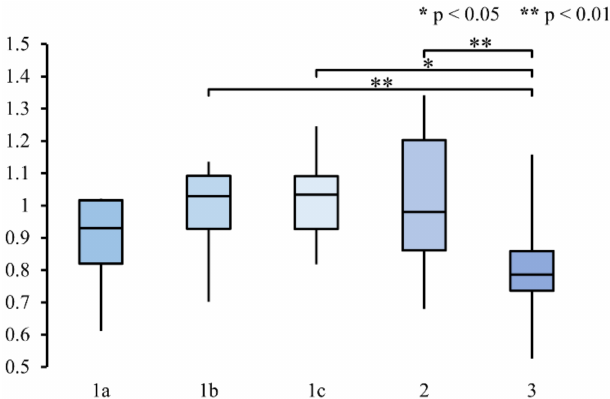
Figure 10. Box plot of the average beta/alpha ratio for each participant and method at Cz. Asterisks (*) denotes significant difference in beta/alpha ratio between the methods as indicated by the Kruskal– Wallis test with Bonferroni correction for multiple comparisons (* for p < 0.05 and ** for p <